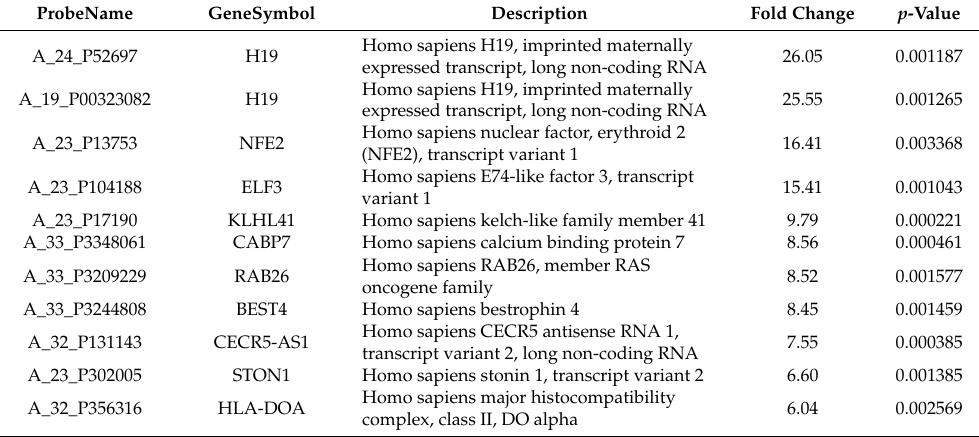
Figure 1. Gene expression analysis of tumor cells in orthotopic and metastatic sites of the orthotopic small cell lung cancer metastasis model. ( A ) Cells from the orthotopic and metastatic sites of the orthotopic metastasis model developed using DMS273 cells were subjected to DNA microarray analysis. ( B ) Schematic representation of the isolation of tumor cells from orthotopic and metastatic sites in the mice. ( C ) A clustering analysis of the 43 differentially expressed genes ( p < 0.01, fold change > 4) between the orthotopic and metastatic tumors. Table 1. List of the 19 genes with higher expression at metastatic sites than at orthotopic sites ( p < 0.01, fold change > 4) in the model. Comparison of the gene expression profiles of the three orthotopic tumors and four metastatic tumors revealed 21 probes with higher expression at metastatic sites than at orthotopic sites. The array includes one or more probes for each gene, and the 21 probes represent 19